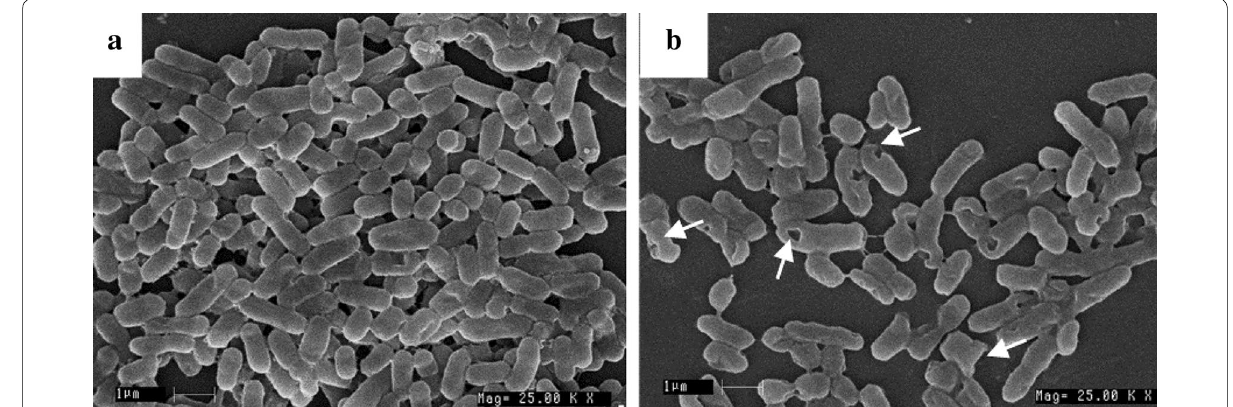
Fig. 3 SEM images of untreated E. coli MTCC-118 ( a ) and E. coli MTCC-118 treated with biosurfactants ( b